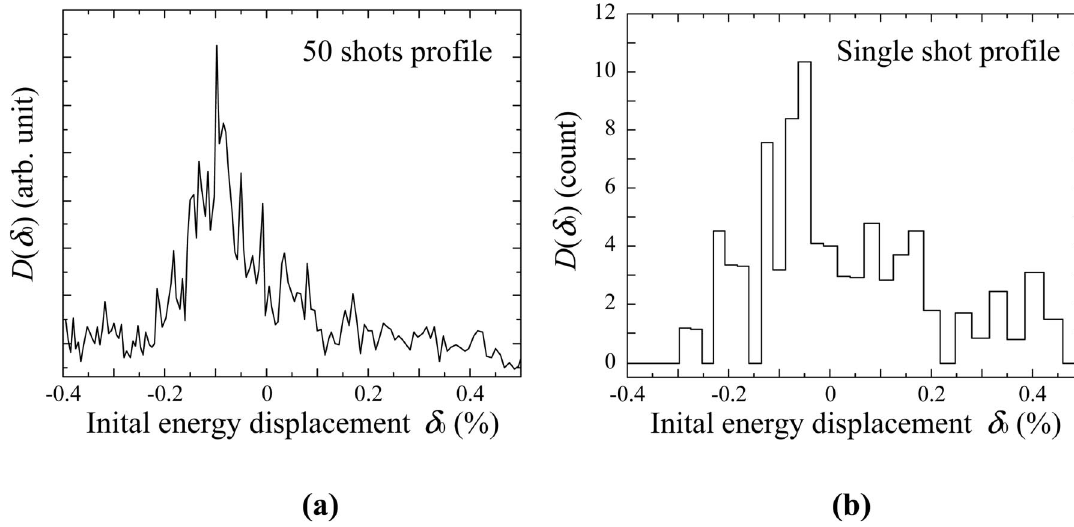
FIG. 10. Energy profiles reconstructed from (a) multishot camera images (accumulations of 50 shots) and (b) a single-shot camera image. The slice width of the oscillation image along the slow-sweep axis is 2 : 0 (cid:5) s (5 revolutions) in (a) and 8 : 1 (cid:5) s (20 revolutions) in (b).